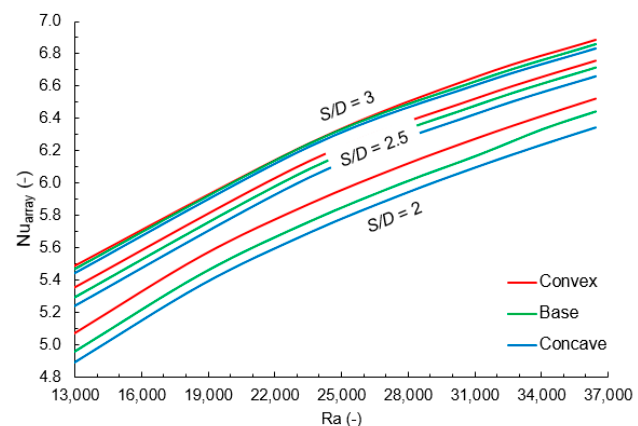
Figure 13. The average Nusselt numbers Nu array for the base, concave, and convex configurations of the tube array 4 × 4 with the different tube ratio spacing S/D .